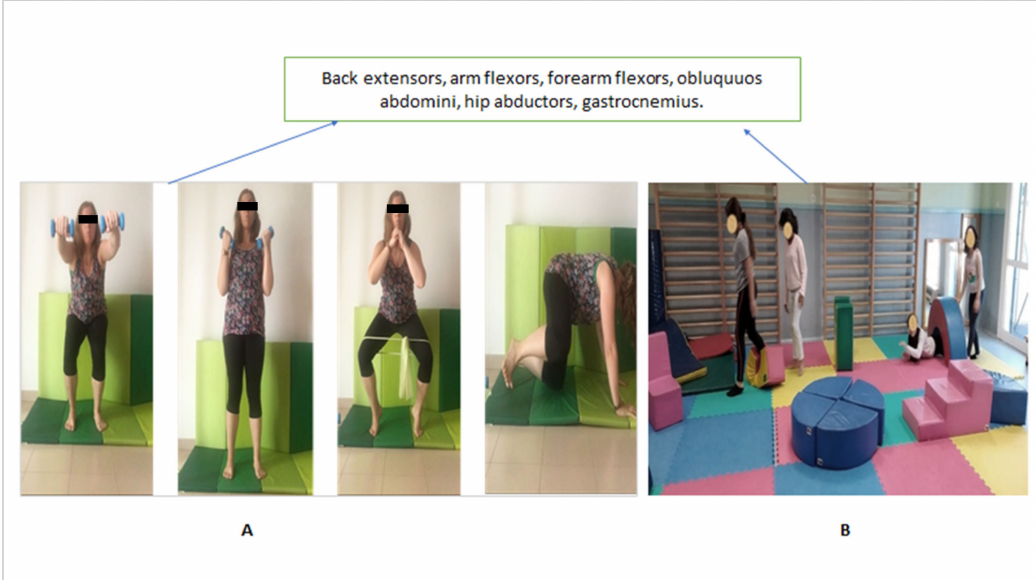
Figure 4. Therapeutic exercise training with the involved muscles: the training lasted 30 min. Part ( A ) is based on the execution of di ff erent exercises for the first 20 min: each exercise is performed for 5 min, with 3 10-rep sets. The first exercise consists of performing a squat while raising the arms to shoulder height, and then going back to the starting position (with arms extended along the body and hips aligned with the feet). In the second exercise, a slight flexion of the knees is performed, flexing and extending the elbows with the dumbbells (the starting position would be the same as in exercise 1). In the third exercise, an elastic band is placed right above the knees. The exercise begins with the legs slightly separated; then, the child tiptoes, flexing the knees slightly and separating the hips. The last exercise begins in quadruped position (distributing the weight among both knees and hands), from which the child transfers the weight of the body to one knee in order to raise the other knee to hip height; then, the child returns to the starting position and repeats the exercise with the other knee. Part ( B ) shows the end of the training, which lasts 10 min. This second part consists of an exercise circuit with di ff erent ludic movements: races, ball throws, jumps, drags, games in pairs and in groups, global movement of the body with rings or other elements, going up and down steps, ramps, etc.